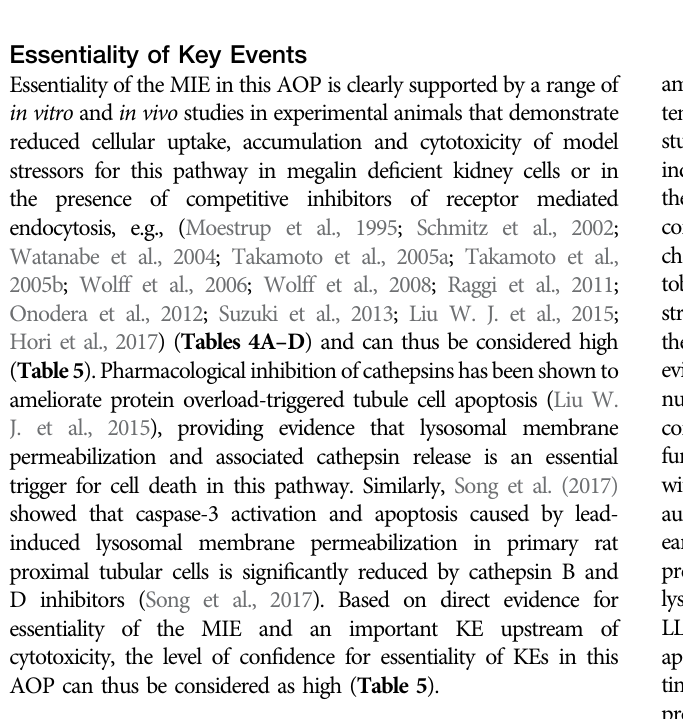
( Table 5 ). Pharmacological inhibition ofcathepsinshasbeen shown to ameliorate protein overload-triggered tubule cell apoptosis (Liu W.